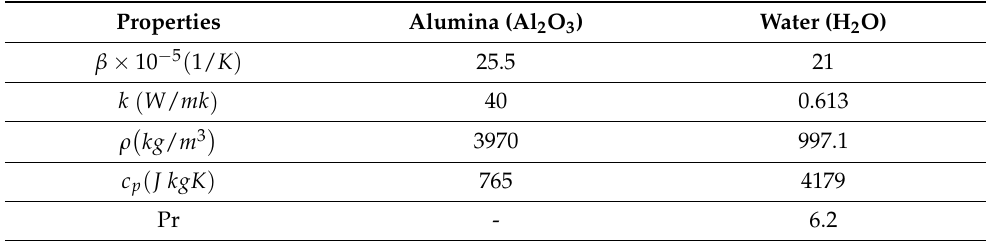
Table 1. Physical data of the base water fluid and alumina nanoparticles.